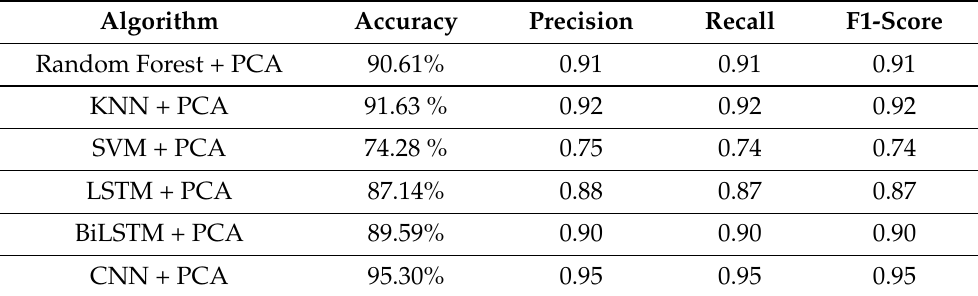
Table 5. Machine learning results using data augmentation with